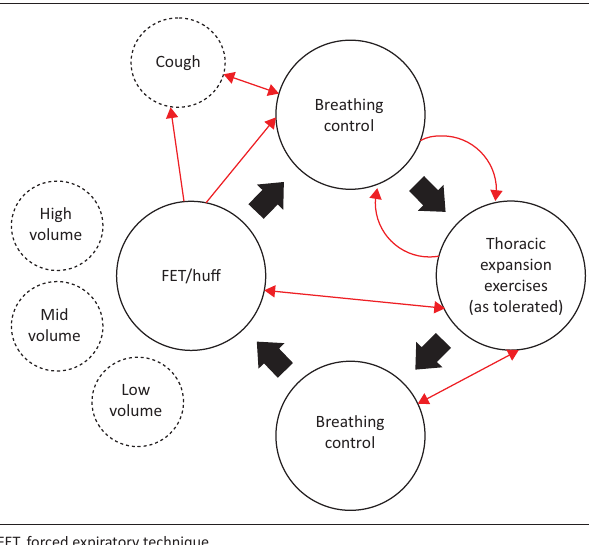
FIGURE 3: Components and examples of variations in the active cycle of breathing